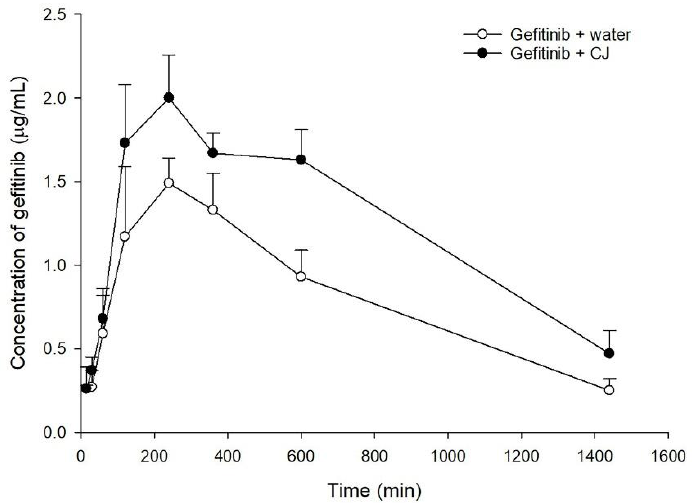
Figure 2. Mean (±S.E.) serum concentration – time profiles of gefitinib after oral administration of gefitinib alone ( ○ , 50 mg/kg) and coadministration with CJ ( • , 5.0 g/kg of cranberry) in rats. Table 1. Mean ( ± S.E.) pharmacokinetic parameters of gefitinib in rats (n = 5 in each group) after giving gefitinib (50 mg/kg) alone and coadministration with CJ (5.0 g/kg of cranberry). Treatments Gefitinib + Water Gefitinib + CJ Parameters T max (min) 264.0 ± 44.9